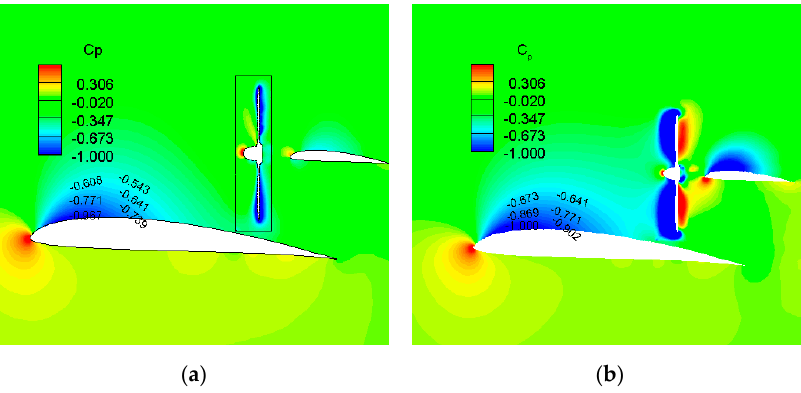
Figure 14. Pressure contours at different rotation speeds: ( a ) 2000 r/min; ( b ) 4000 r/min. ( Ma = 0.1017, α = 2 ◦ , medium grid).